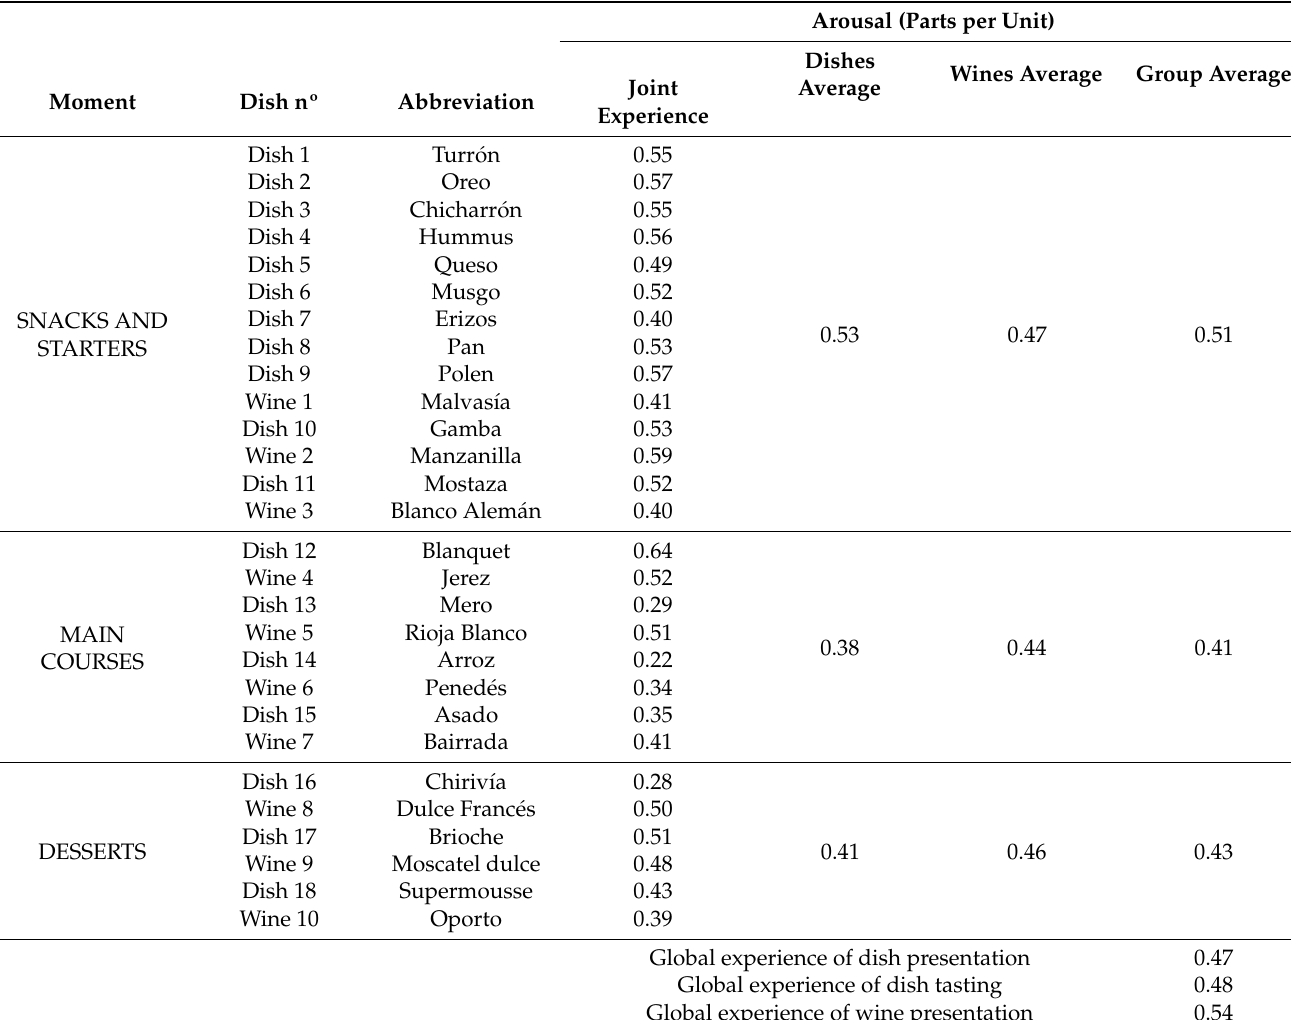
Table 2. GSR quantitative results summary for GSR. Source: Prepared by the authors.